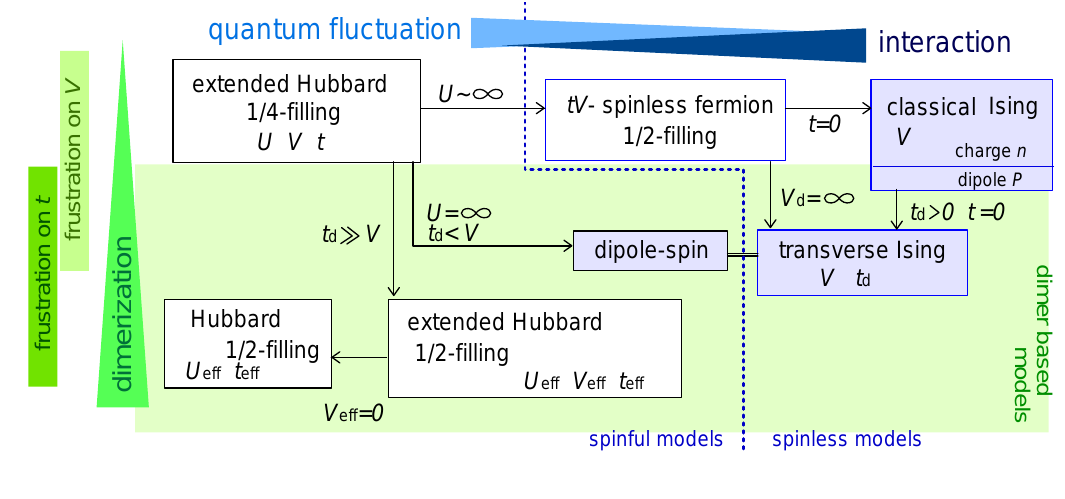
and t d d , V , t are the ones on/between eff eff eff